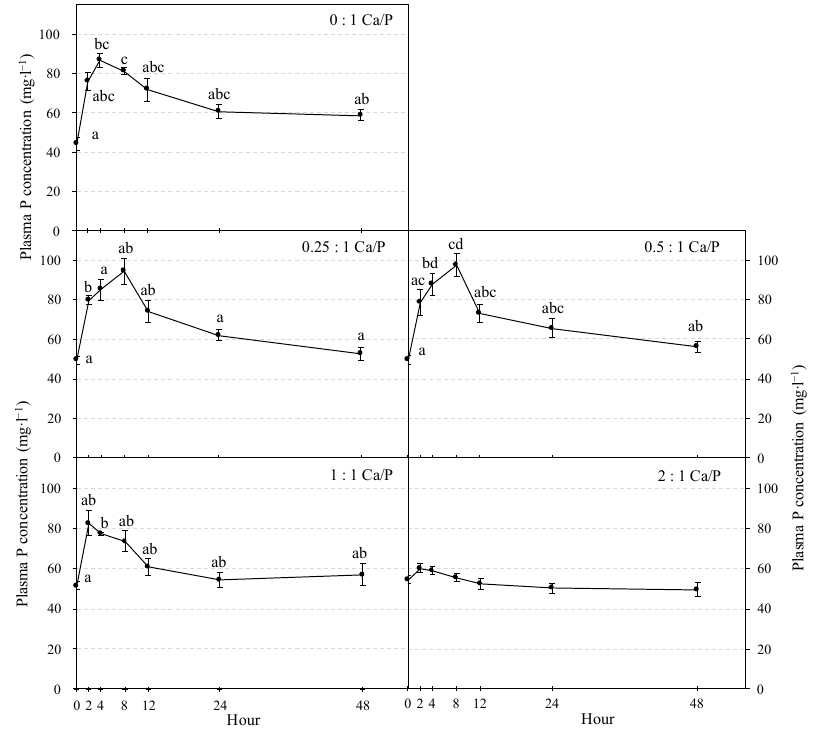
Figure 1. Plasma phosphorus (P) concentration of hybrid sturgeon ( Huso dauricus ♀ X Acipenser schrenckii ♂ ) after being intubated with 100 mg P·kg − 1 BW at different Ca/P ratios. Different letters indicate significant differences among the different time points in each treatment ( p < 0.05). As with plasma P, the fish in all the treatments had the similar basal level of plasma Ca content at first measurement post intubation (0 h) (Figure 2). No significant variation of plasma Ca concentration was observed in the treatments with Ca/P ratios of 0:1, 0.25:1, 0.5:1, and 1:1 ( p > 0.05). The concentration of plasma Ca remained stable at the base level during the 48 h post intubation period. Fish treated with Ca/P ratio of 1:1 showed an in- crease in plasma Ca during the first 2 h, but no significant difference was found ( p > 0.05). Plasma Ca concentration was significantly affected in the fish where the highest dose of Ca was administrated (Ca/P ratio of 2:1) ( p < 0.05). The content of Ca in plasma notably increased and reached the peak at 2 h post intubation ( p < 0.05), then gradually decreased over time and showed no significant difference with initial level after 8 h post intubation ( p > 0.05).